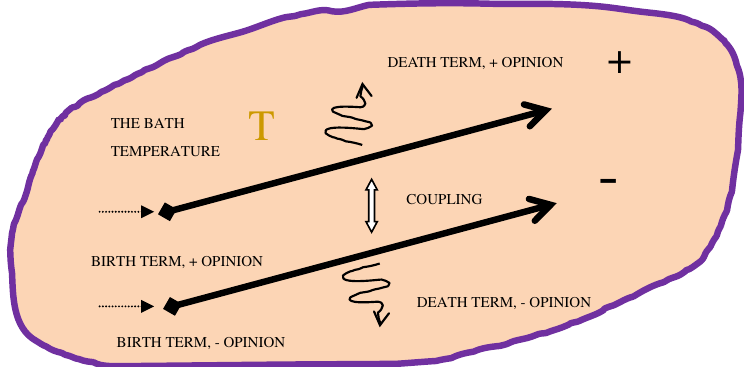
Fig. 2. Illustration of the society-deciders model. The structures representing the nation, where the bulk is the society with temperature T and the deciders' potentials' curves are represented with the inclined curves, where the arrows represent the deciders °ow (either from the system (curly arrows) or between opinions or inside the system (broken